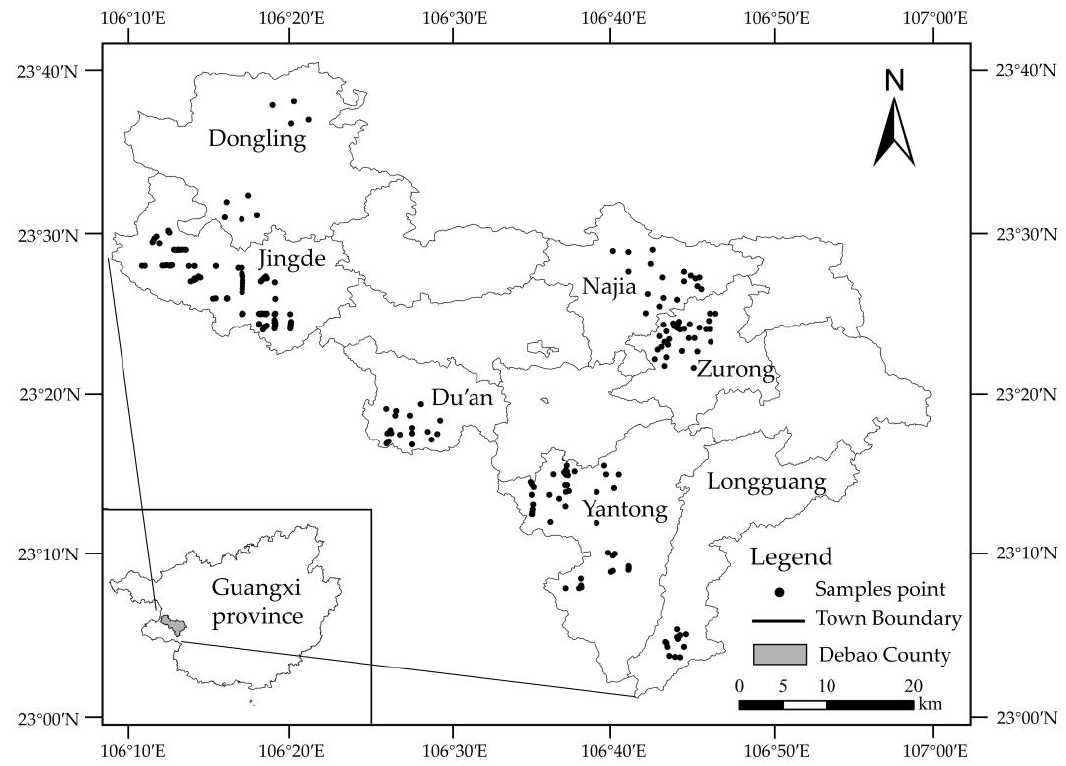
Figure 1. Spatial distribution of tobacco planting soil sampling location in Debao County.